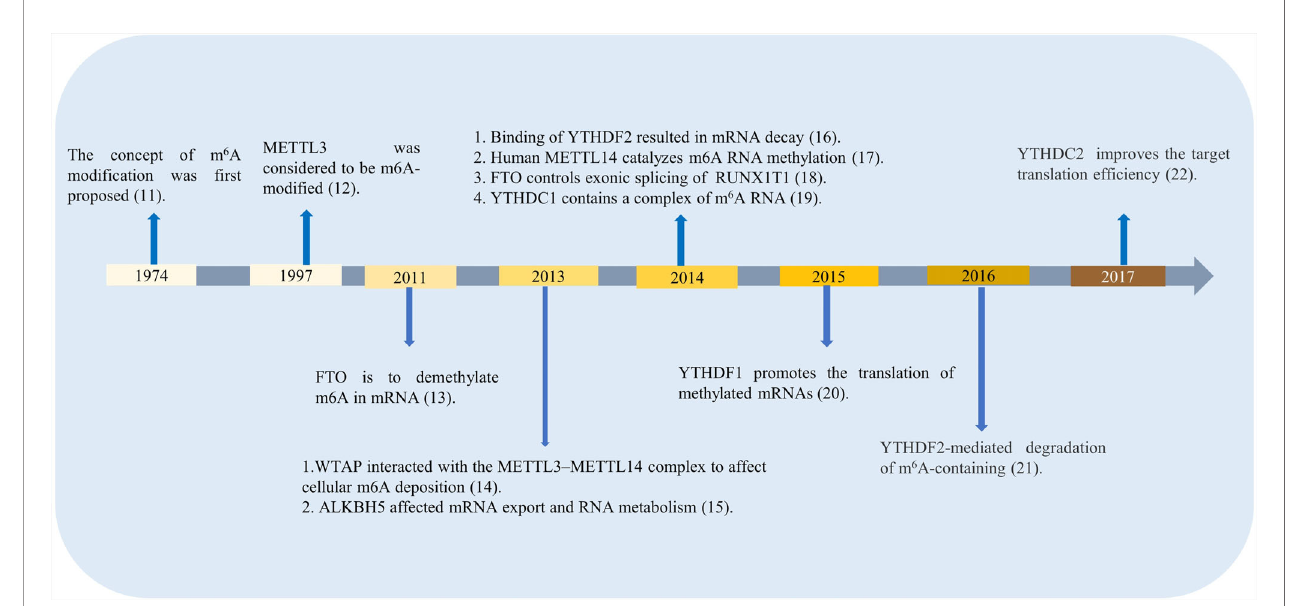
FIGURE 1 | Time for discovery and functions of m6A-related enzymes and proteins.